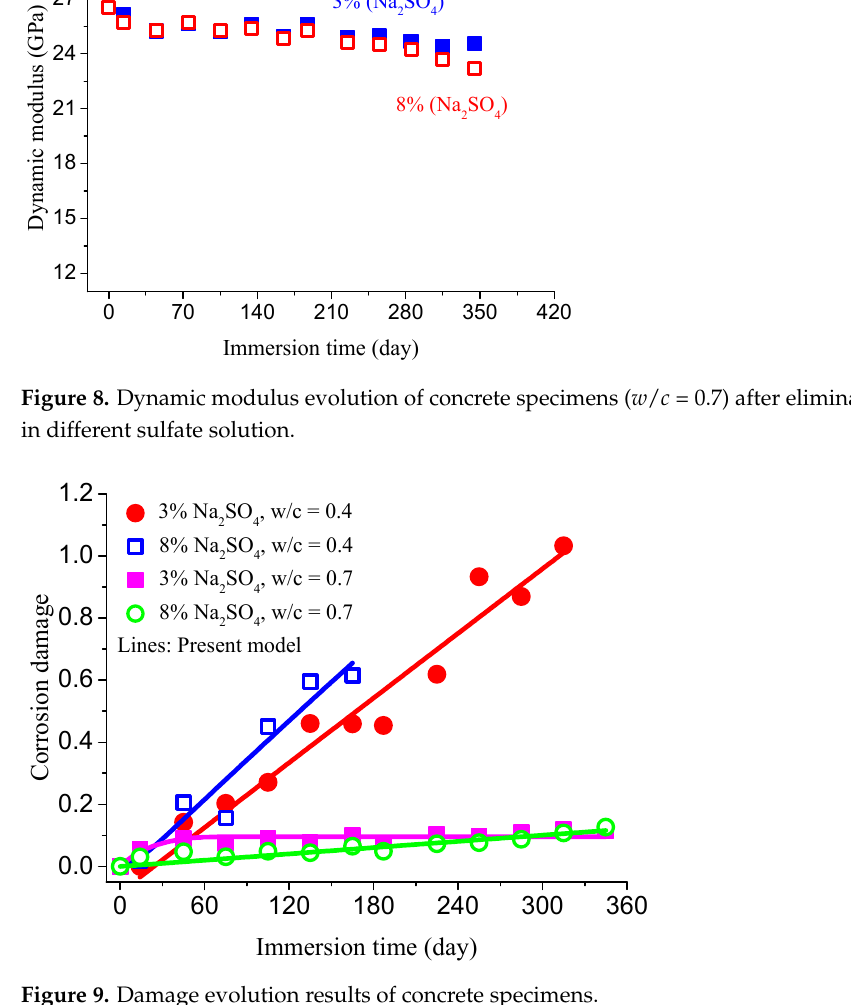
Figure 9. Damage evolution results of concrete specimens.